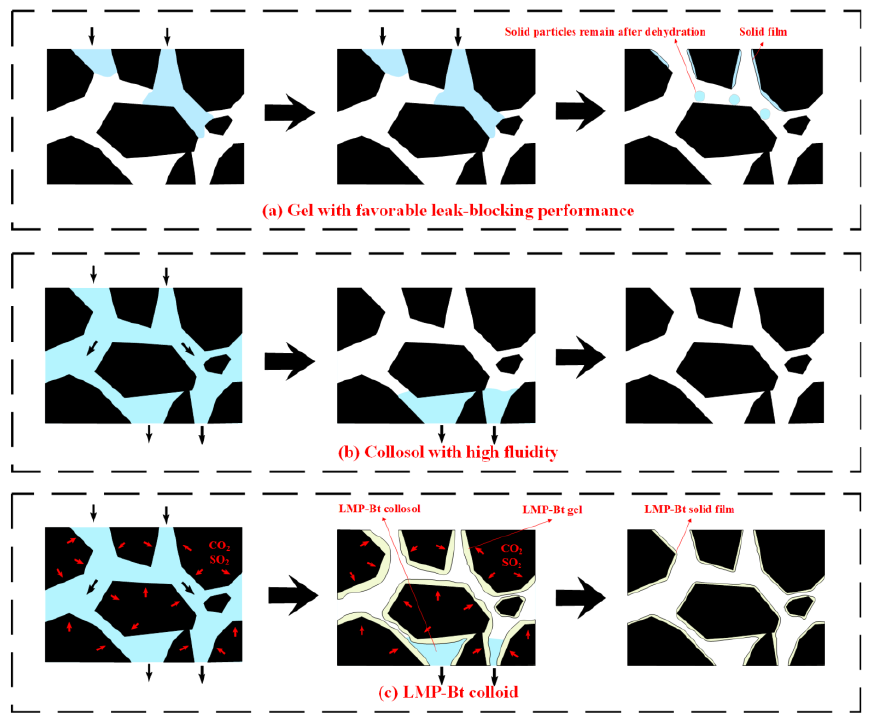
Figure 1. Fluidity and oxygen isolation of colloid: ( a ) Gel with favorable leak-blocking performance, ( b ) Collosol with high fluidity and ( c ) LMP-Bt colloid.